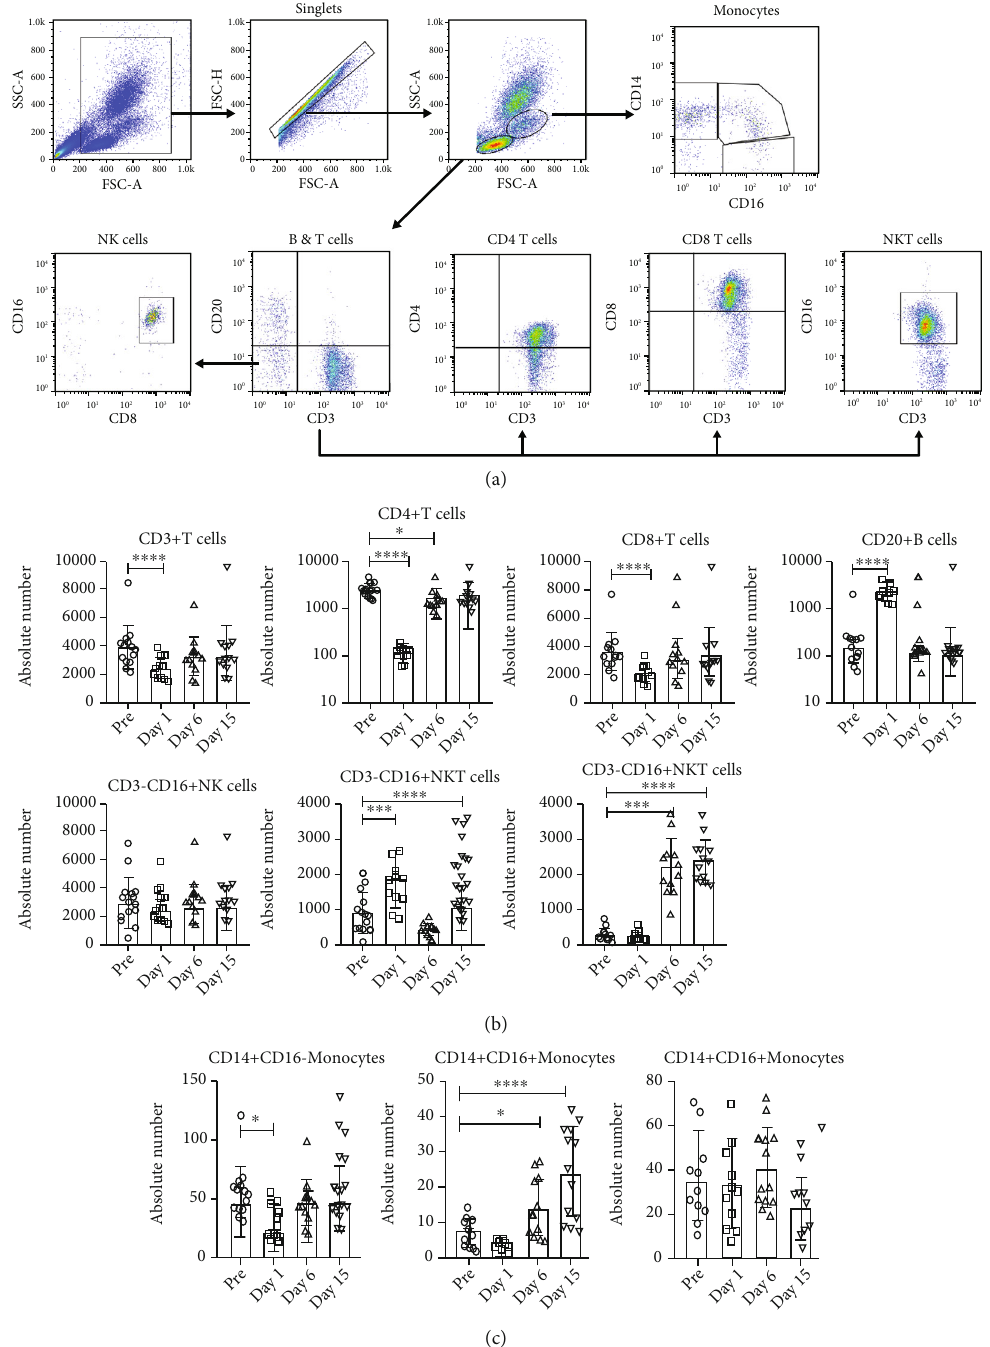
Figure 3: (a) Representative gating strategy showing phenotype analyses of the various cell markers in the peripheral blood. The lymphocytes and monocytes were fi rst gated based on forward scatter (FCS) versus side scatter (SSC); CD3 + , CD4 + , CD8 + , and CD20 + cells and NK and NKT cells were positively identi fi ed from the lymphocyte subset. Monocytes and subsets were identi fi ed from monocyte-gated population by CD14 and CD16 expression. The speci fi city of staining for the various markers was ascertained according to the isotype control antibody staining used for each pair of combination markers, as shown. (b) Phenotype and absolute number analysis of lymphocyte subsets from squirrel monkeys. Aliquots of EDTA whole blood were stained with fl uorescence-labeled antibodies to the CD3 + , CD4 + , CD8 + , CD16+, and CD20 + to identify lymphocyte subpopulations pre- and posttransportation and relocation. Values on the y -axis are absolute lymphocyte cells. p values were considered statistically signi fi cant at p < 0 : 05 . (c) Phenotype and absolute number analysis of monocyte subsets from squirrel monkeys. Aliquots of EDTA whole blood were stained with fl uorescence- labeled antibodies to the CD3 + , CD14 + , and CD16 + to identify monocyte subpopulations pre- and posttransportation and relocation. Values on the y -axis are absolute lymphocyte cells. p values were considered statistically signi fi cant at p < 0 : 05